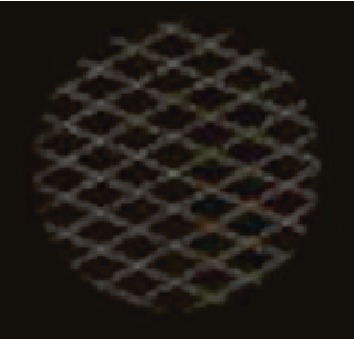
Textile electrode.